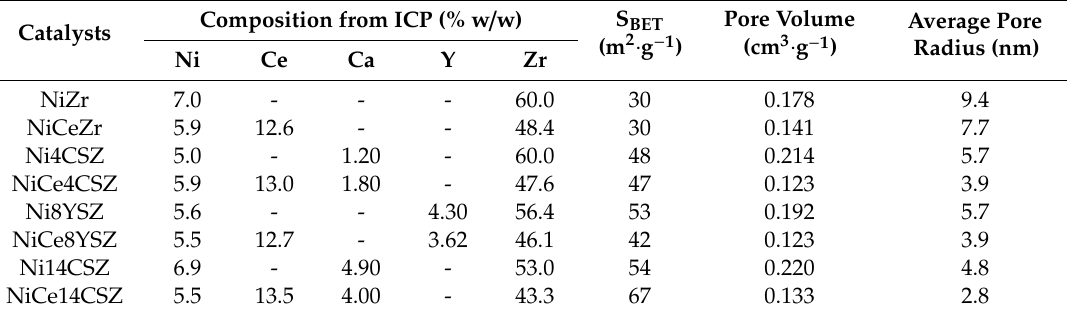
Table 1. Composition and textural